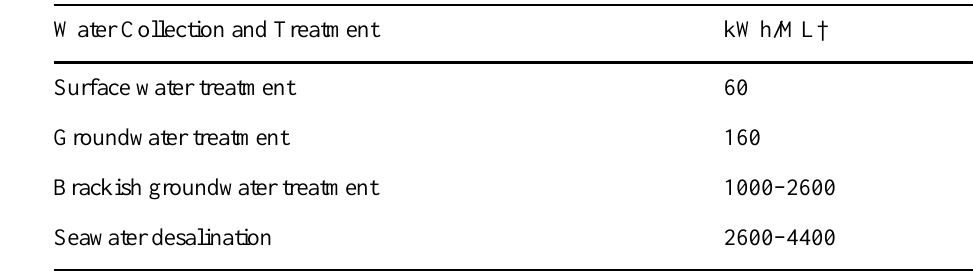
Table 3 . National average electricity use for water collection and treatment using different water treatment technologies (Goldstein and Smith 2002b, California Energy Commission 2005). Distribution represents additional energy